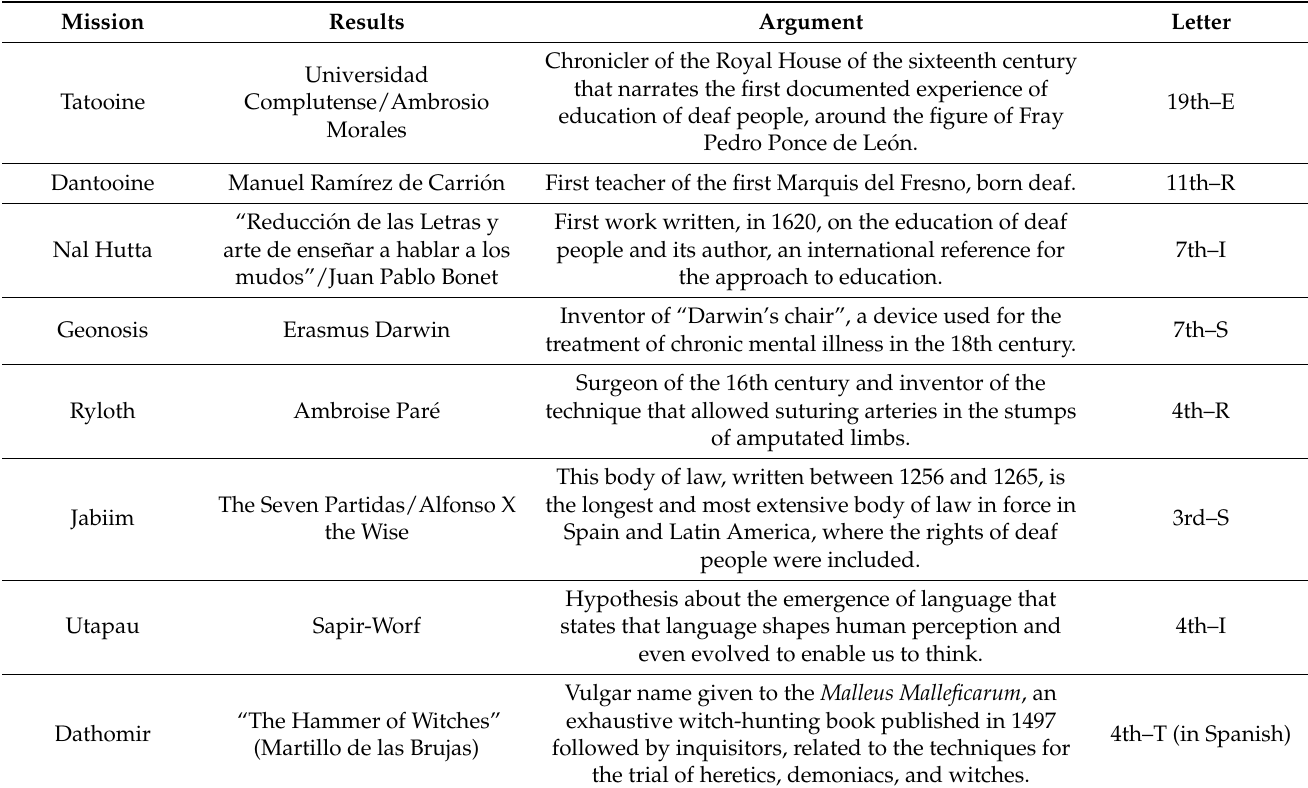
Table 1. List of missions and